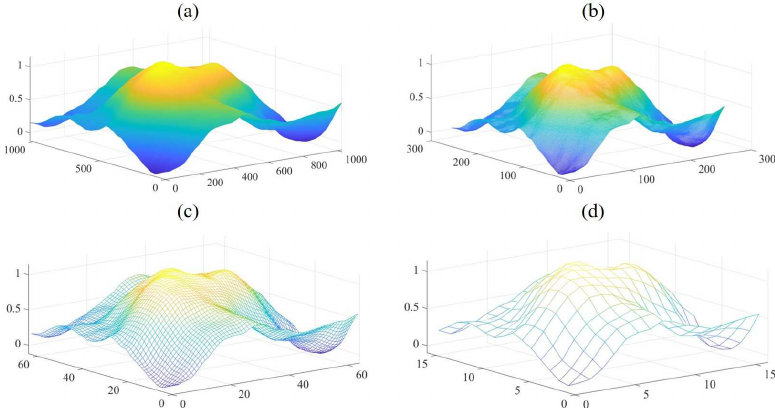
Figure 4. Schematic diagram of reducing number of picture elements in sampling process. ( a ) 8192 × 8192; ( b ) 256 × 256; ( c ) 64 × 64; ( d ) 16 ×